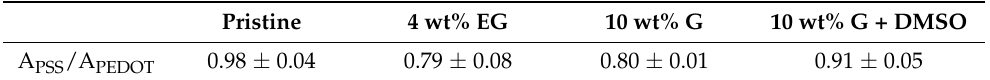
Table 3. Ratio of PSS (A PSS /A PEDOT ) in PEDOT:PSS thin films prepared from dispersions with different